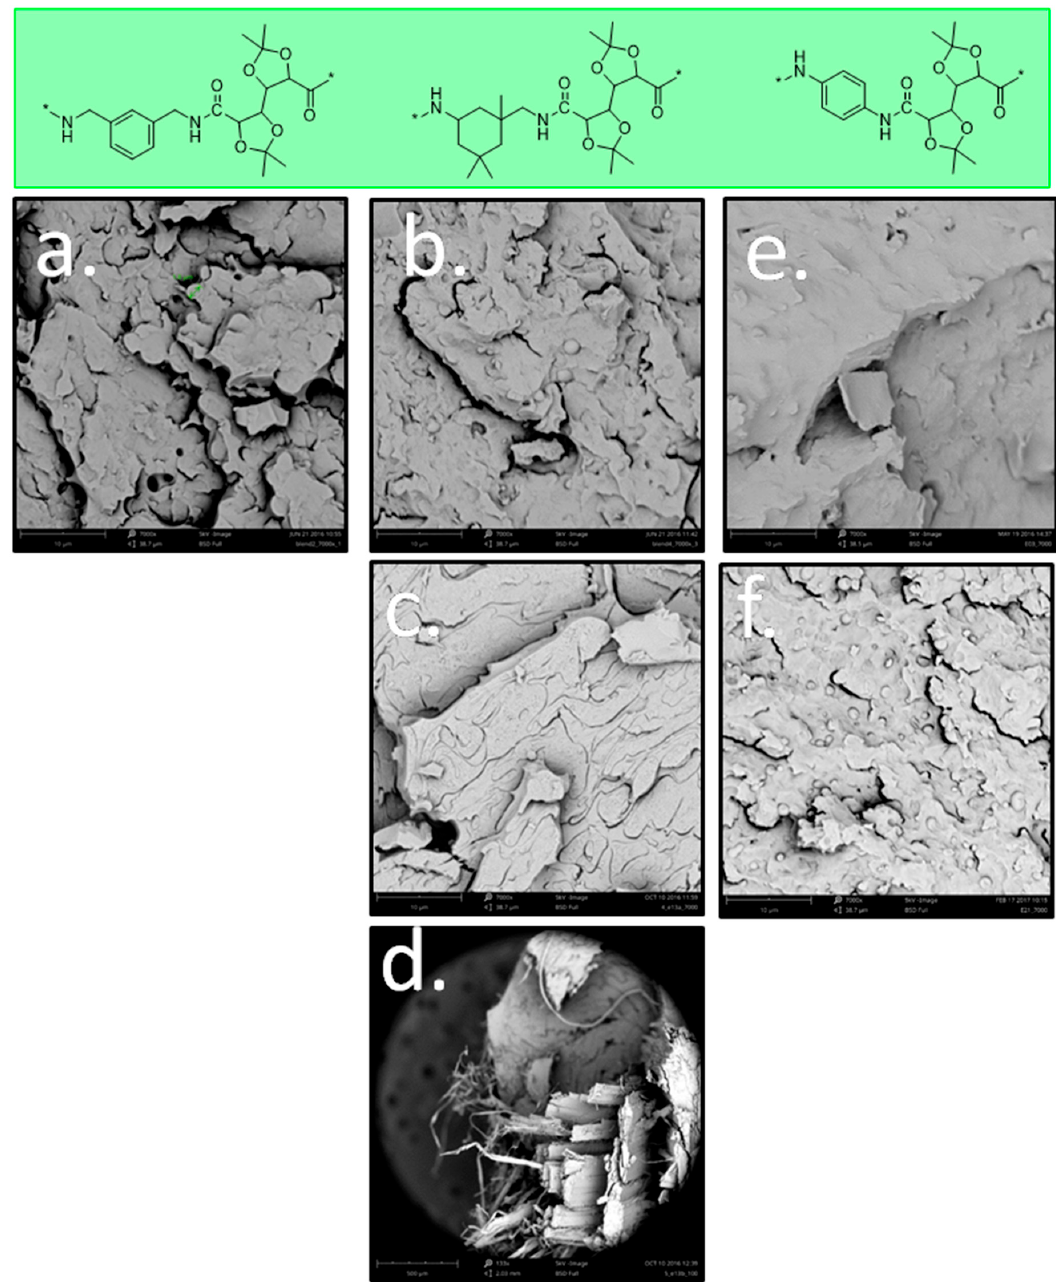
Figure 6. SEM images of blends ( a ) PA(6,12) 50 PA(MXD,GalXMe) 50 (7000×), ( b ) SEM images of blends ( a ) PA(6,12) 50 PA(MXD,GalXMe) 50 (7000 × ), ( b ) PA(6,12) 50 PA(6,12) 50 PA(IPDA,GalXMe) 50 (7000×), ( c ) PA(PACM,12) 50 PA(IPDA,GalXMe) 50 (7000×), ( d ) PA(IPDA,GalXMe) 50 (7000 × ), ( c ) PA(PACM,12) 50 PA(IPDA,GalXMe) 50 (7000 × ), ( d ) PA(PACM, PA(PACM,12) 50 PA(IPDA,GalXMe) 50 (133×), ( e ) PA(6,12) 50 PA(PPDA,GalXMe) 50 (7000×), and ( f ) 12) 50 PA(IPDA,GalXMe) 50 (133 × ), ( e ) PA(6,12) 50 PA(PPDA,GalXMe) 50 (7000 × ), and ( f ) PA(PACM,12) 50 PA(PACM,12) 50 PA(PPDA,GalXMe) 50 (7000×). PA(PPDA,GalXMe) 50 (7000 ×